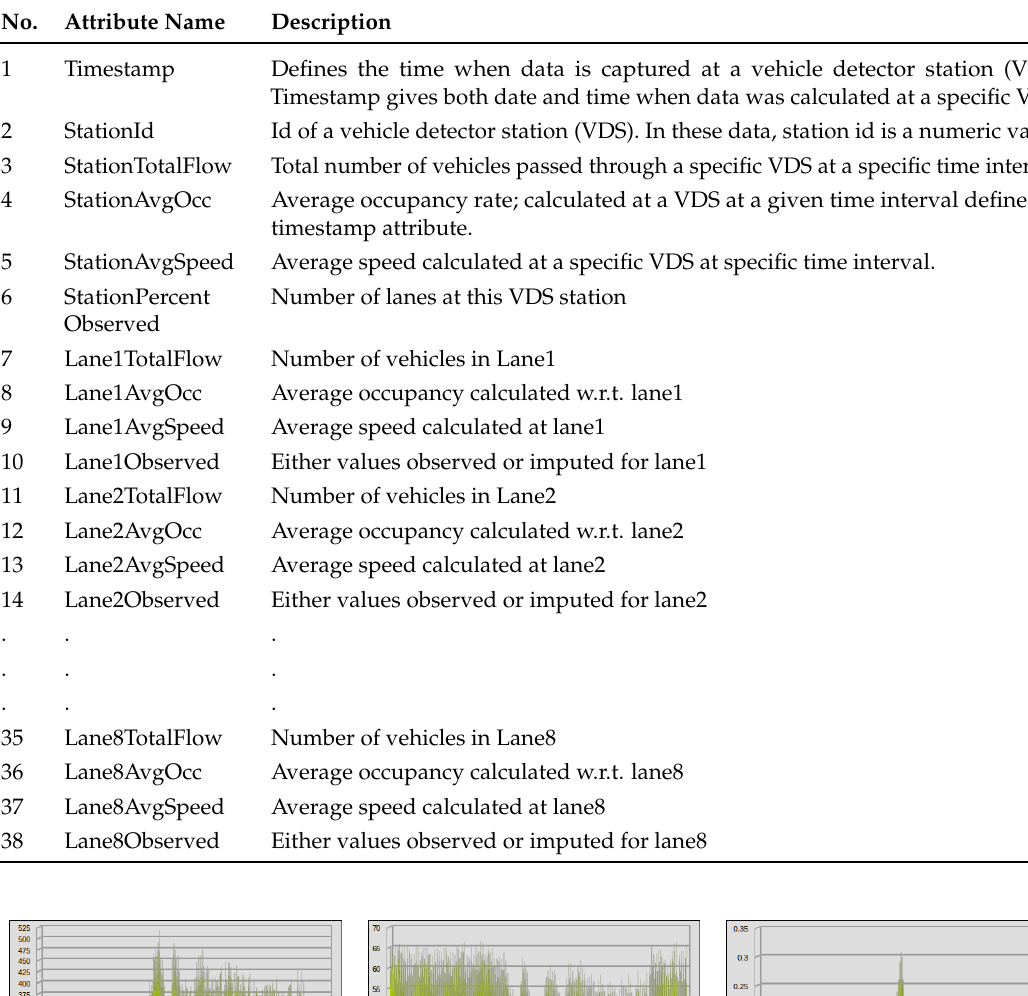
Table 1. Schema of vehicles dataset.